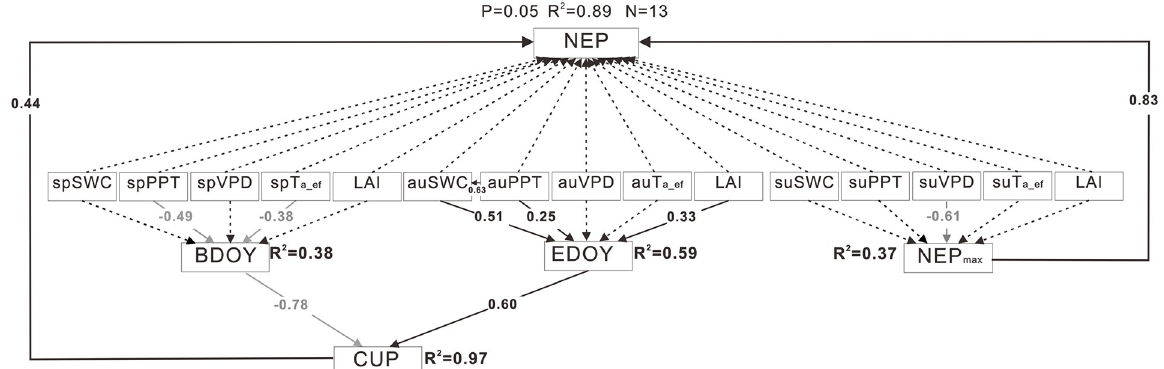
Fig 4. Results of structural equation modeling (SEM) of the relationships among annual anomalies of climatic and biotic variables, carbon dioxide uptake period (CUP) and maximum daily net ecosystem production (NEP max ) and net ecosystem production (NEP) in an individual year. Black arrows indicate significant positive relationships, while gray arrows indicate significant negative relationships (P < 0.05). Black dashed arrows indicate insignificant relationships (P > 0.05). Numbers adjacent to arrows are path coefficients indicating the effect size of the relationship. The proportion of variance explained is given by R 2 . sp, su, and au indicate spring, summer, and autumn, respectively.